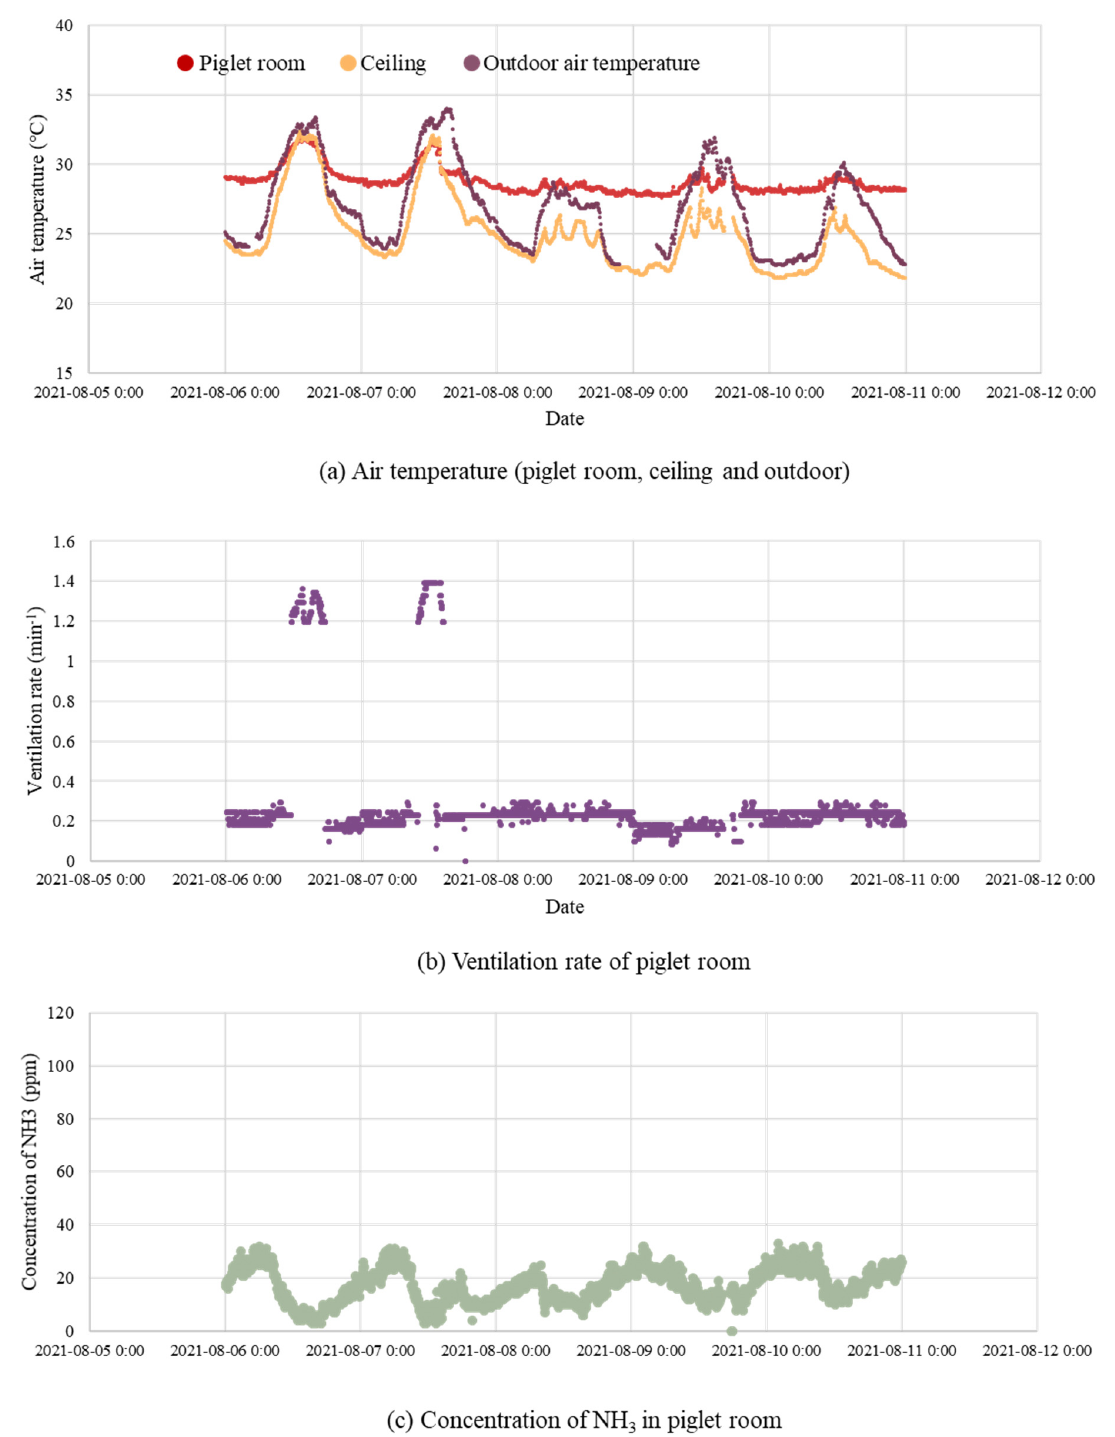
Figure 8. The air temperature, ventilation rate, and ammonia gas results measured in experimental piglet house in summer season. Data analysis period of 6 August (5 weeks piglet) when heat stress was occurred.